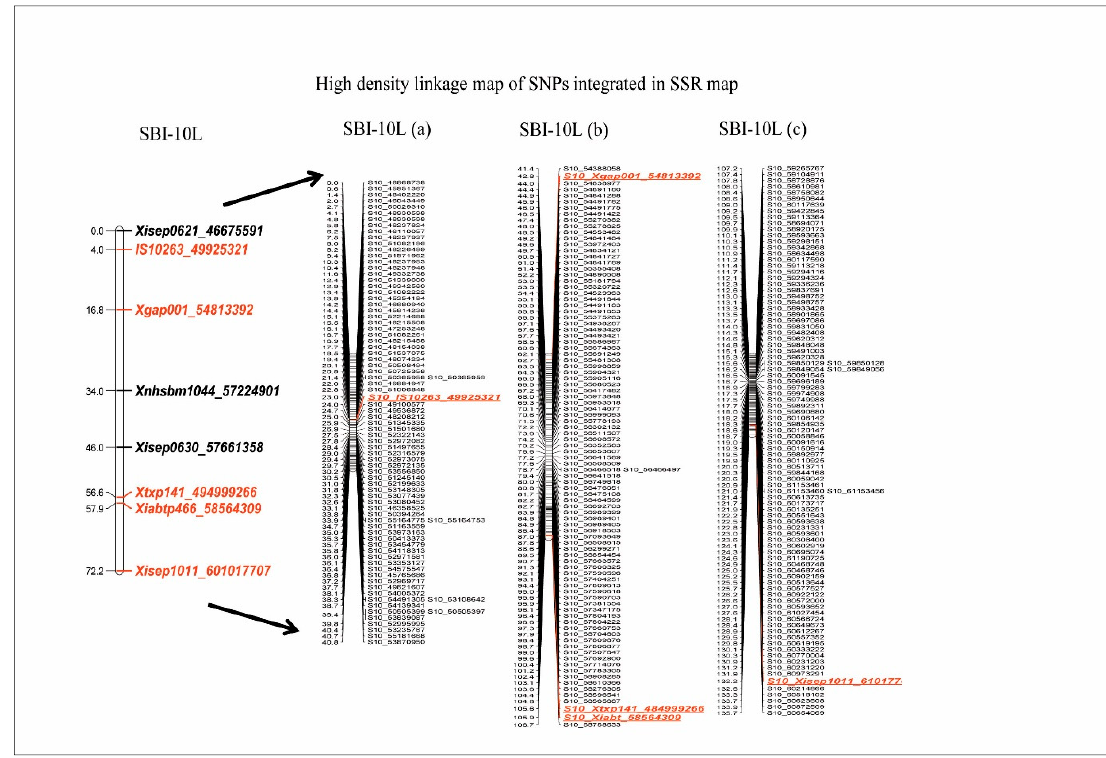
Figure 3. SBI-10L SSR map integrated with the horseshoe aligned SNP markers with linkage map distances estimated using the JoinMap.